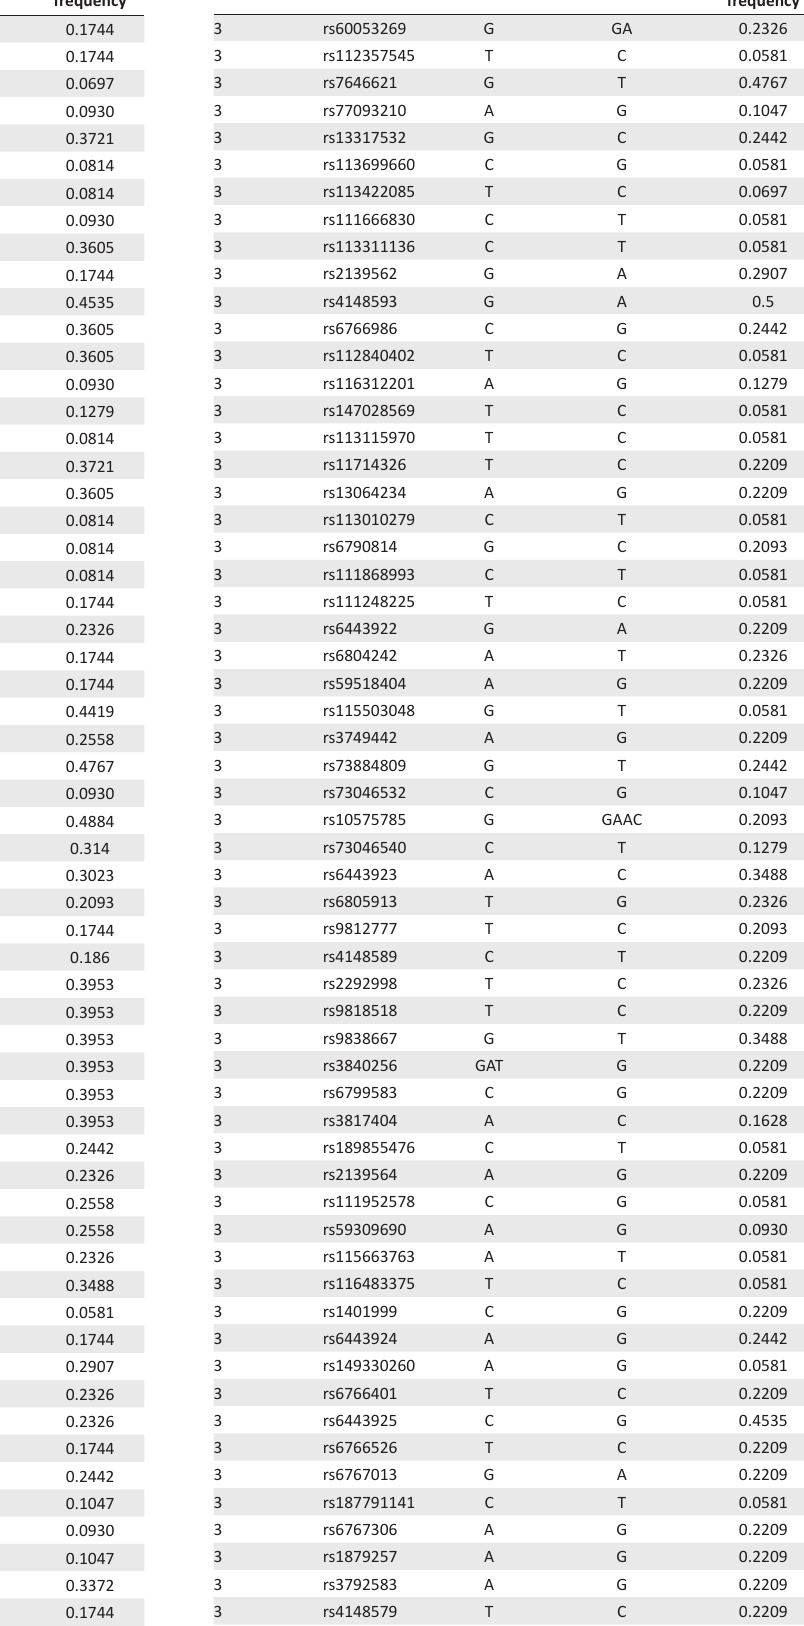
Table 1-A1: Minor allele frequencies for 1846 polymorphisms in 43 black South Africans. Chromosome Polymorphism Minor allele Major allele